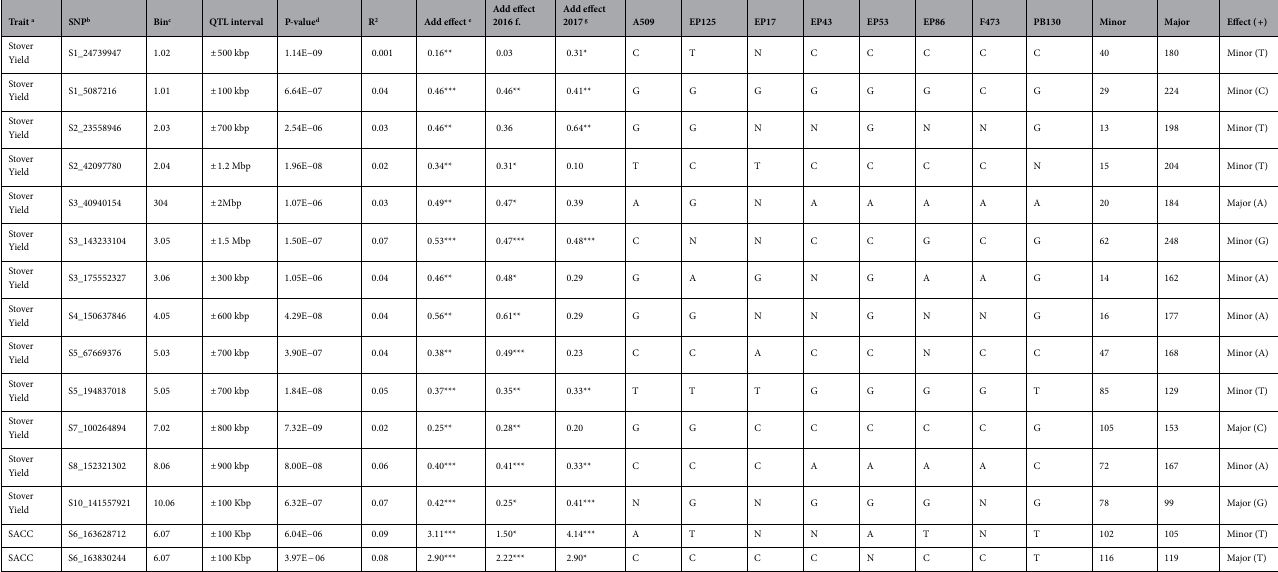
Table 2. SNPs significantly associated with stover saccharification efficiency (SACC) and stover yield, including the QTL interval, p-value for the association between the SNP and the phenotype, additive effect for the SNP (across years, 2016, 2017), parental lines alleles, minor and major frequency alleles and favourable allele. *p < 0.05. **p < 0.01. ***p < 0.001. a SACC Saccharification efficiency. b The number before the underscore indicates the chromosome number and the number after the underscore indicates the physical position in bp within the chromosome. c A bin is the interval that includes all loci from the leftmost or top Core